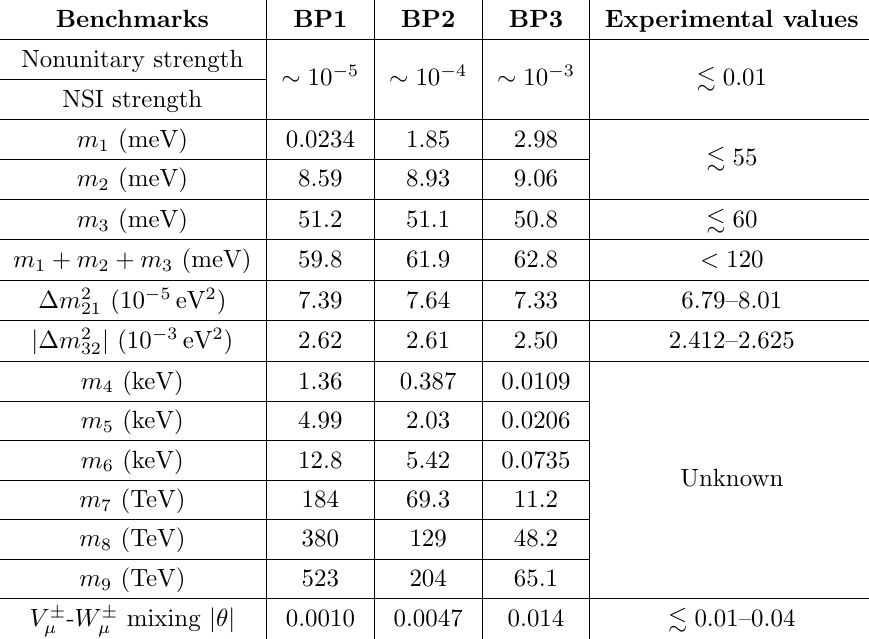
Table 4 . The computed values of neutrino masses, e(cid:11)ective neutrino interaction strength and V (cid:6) - W (cid:6) mixing for our (cid:22) (cid:22)